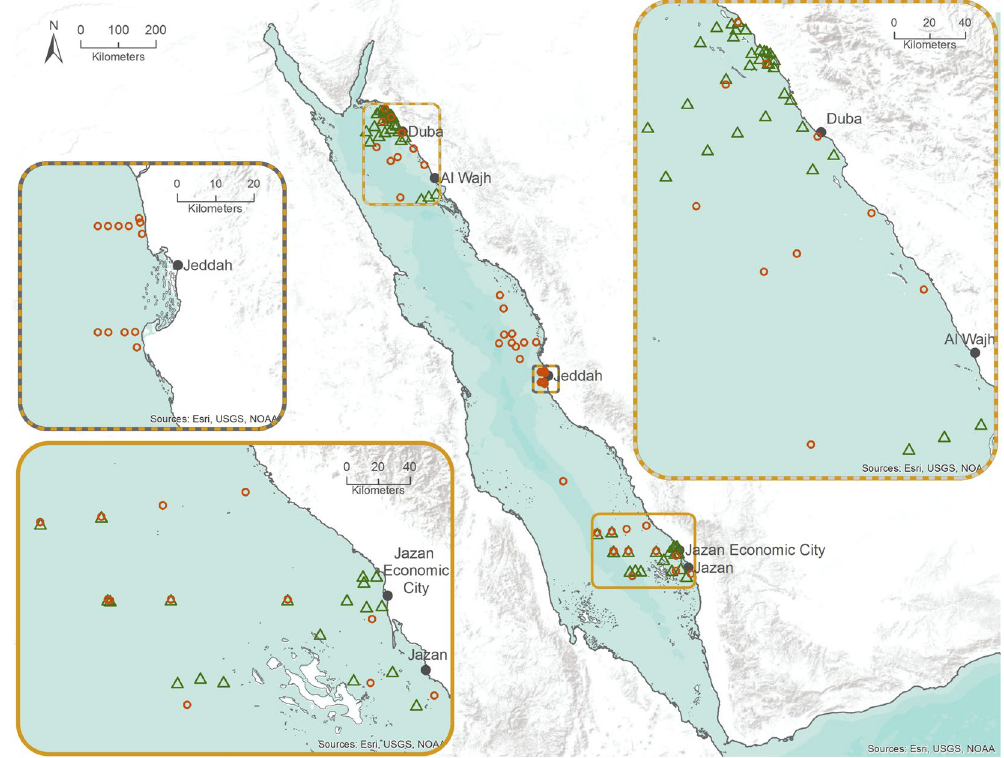
Figure 7. Sampling stations in the north, central and south of the Red Sea. Green triangles represent fall sampling points while orange circles are spring sampling. The map was made in ArcGIS (version: 10.3.1;